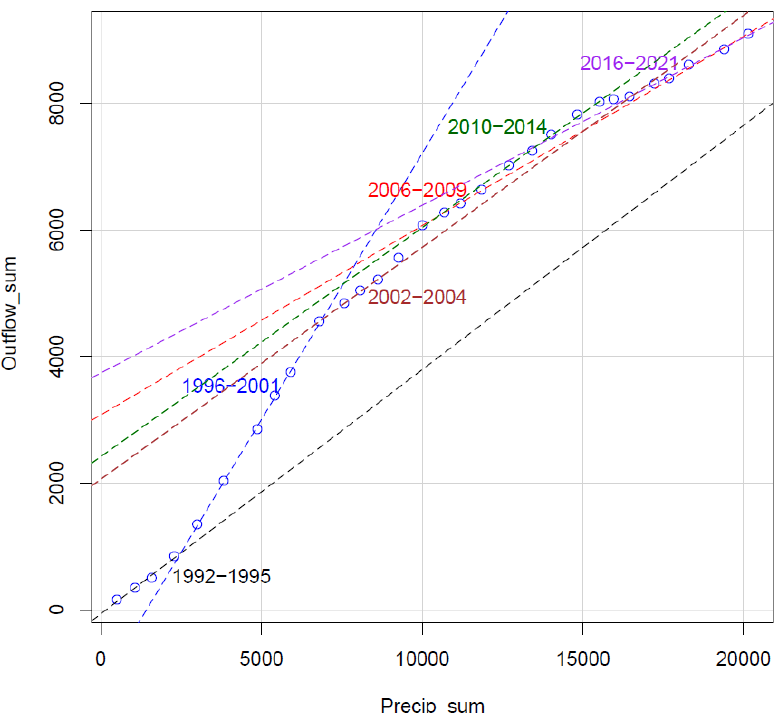
Figure 8. Double mass curve of the precipitation (Precip_sum) and outflow (Outflow_sum) on the catchment during the growing season (blue circles) with linear regressions of significant periods. Regression line of each period is represented by specific colour and year range. Years 1992–1995 represent calibration period before the hydromelioration network was modified and optimised. For regression coefficients, see Table 1. Table 1. Double mass curve regression coefficients of significant periods of precipitation and out- flow. Notes: p = significance of the regression coefficients of slope; Statistical group = unlike letters depict statistically different groups of regression slopes.